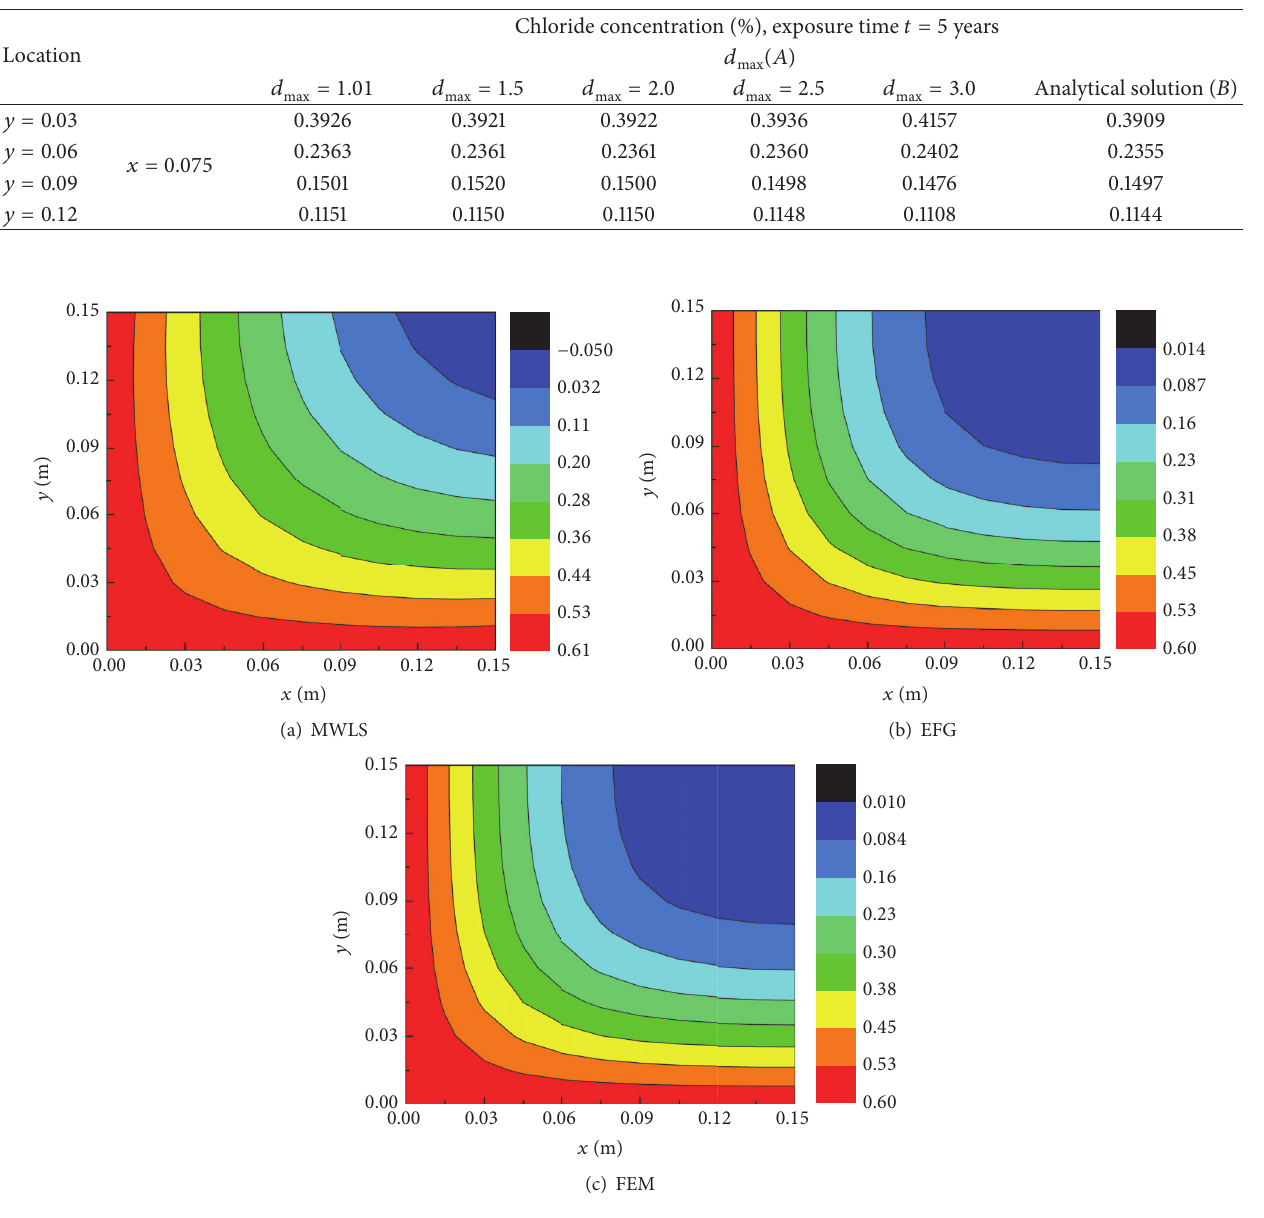
Figure 6: Distribution of chloride concentration: (a) MWLS, (b) EFG, and (c) FEM at exposure time 𝑡 = 10